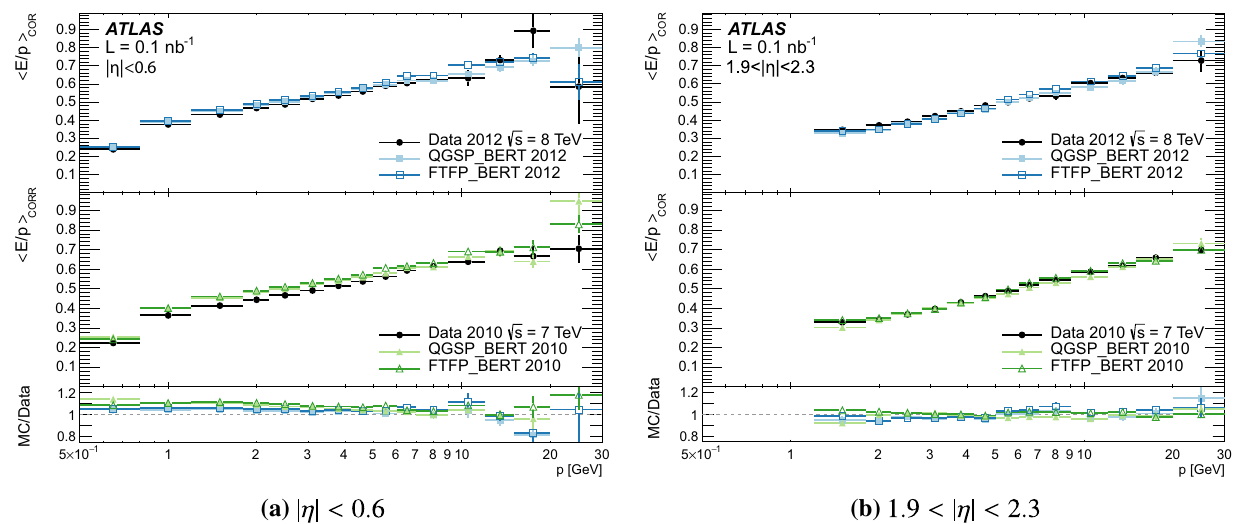
Fig. 21 The average (cid:7) E / p (cid:8) ratio as a function of the track momentum p , for a tracks within | η | < 0 . 6 and b tracks within 1 . 9 < | η | < 2 . 3. Data from isolated tracks recorded in 2010 and 2012 with insignifi-